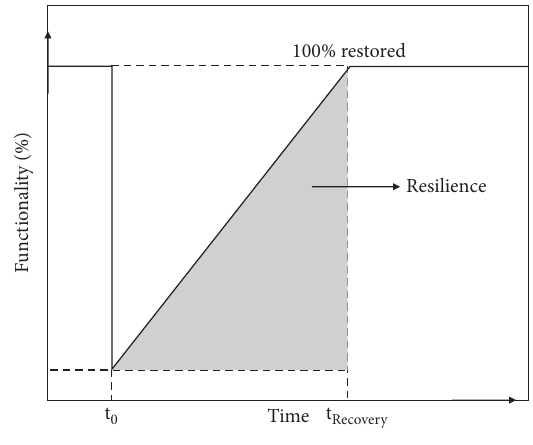
Figure 2: Resilience